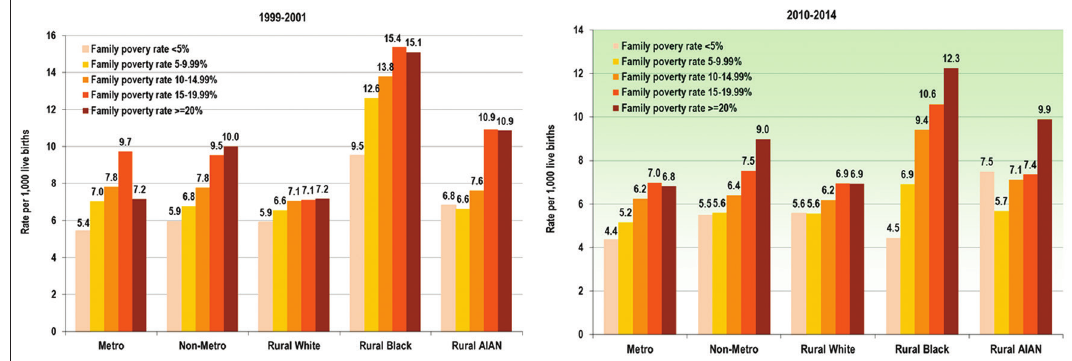
Figure 10. Infant Mortality Rate by County-Level Family Poverty Rate, United States, 1999-2001 and 2010-2014 Source: Data derived from the National Vital Statistics System.